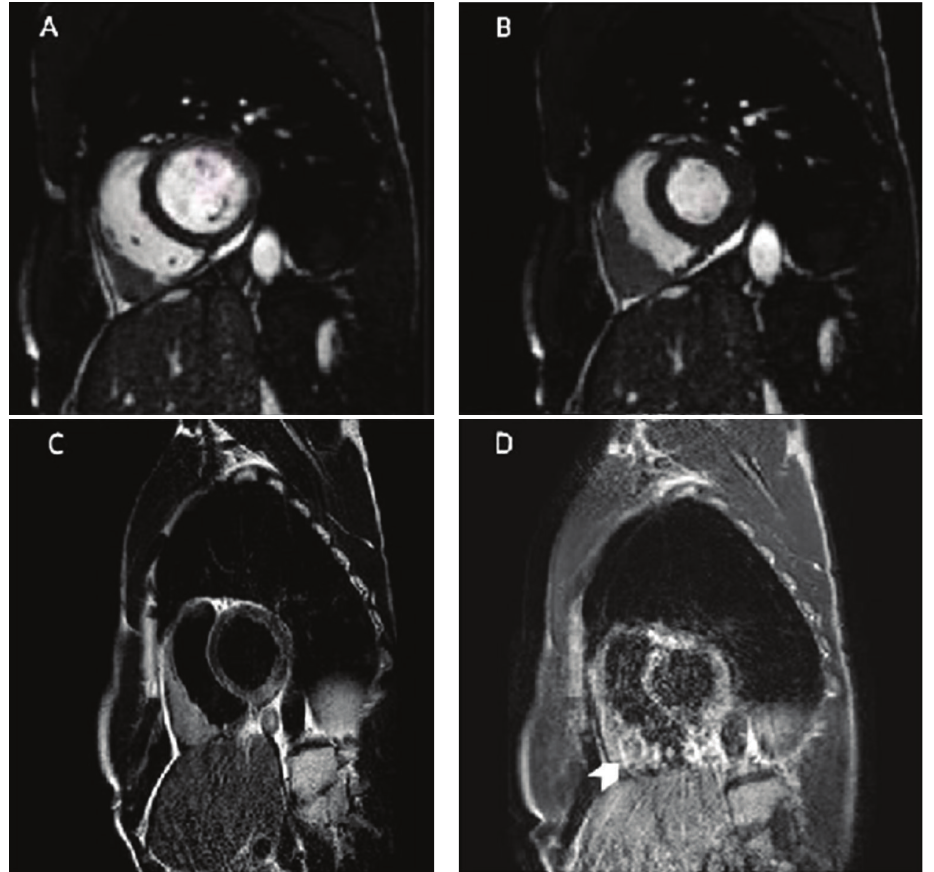
Figure 2: Short-axis diastolic (a) and systolic (b) phase clearly showing the large solid mass anteriorly to the right ventricle. (c) Short-axis T2w black-blood image easily depicting the hyperintense mass that largely infiltrates the myocardium of right ventricular wall which is thinned or completely undistinguishable from the pathological tissue. (d) Short-axis late gadolinium image showing the progressive ring enhancement of the lesion (arrow head), which was interpreted as a probable secondary malignant